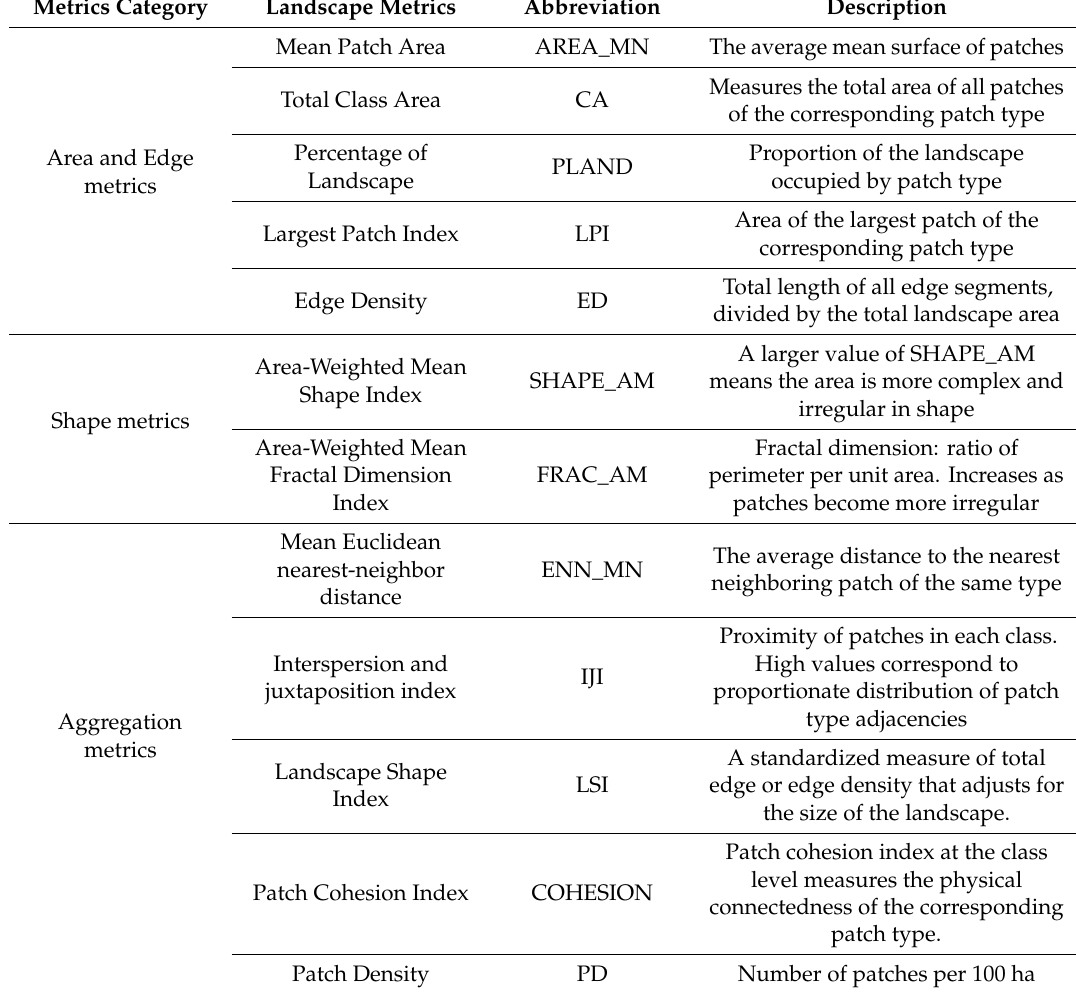
Table 1. Abbreviations and descriptions of landscape configuration